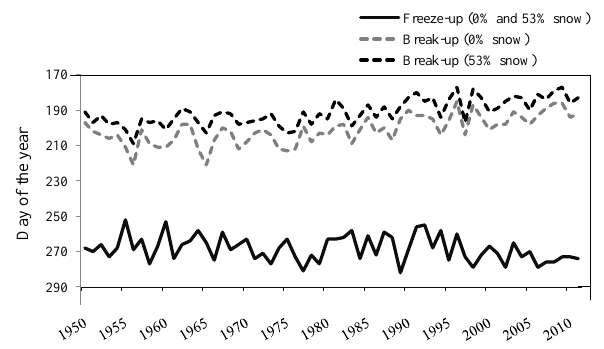
Fig. 7. CLIMo-simulated freeze-up and break-up dates from 1950 to Figure 7. CLIMo-simulated freeze-up and break-up dates from 1950 to 2011. 805